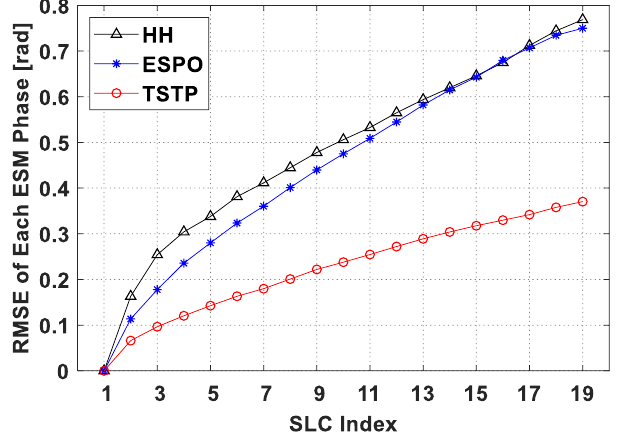
Figure 2. RMSE comparison of each ESM phase using the HH, ESPO, and proposed TSTP algorithms under the number of looks L = 60 and the temporal decorrelation threshold thres = 100.